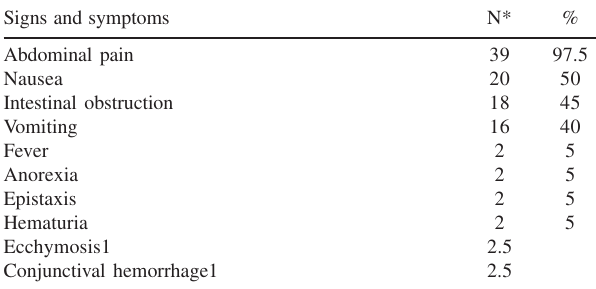
Table 1 - Signs and symptoms present upon admission in 40 patients diagnosed with spontaneous small bowel hematoma due to the use of oral anticoagulation.